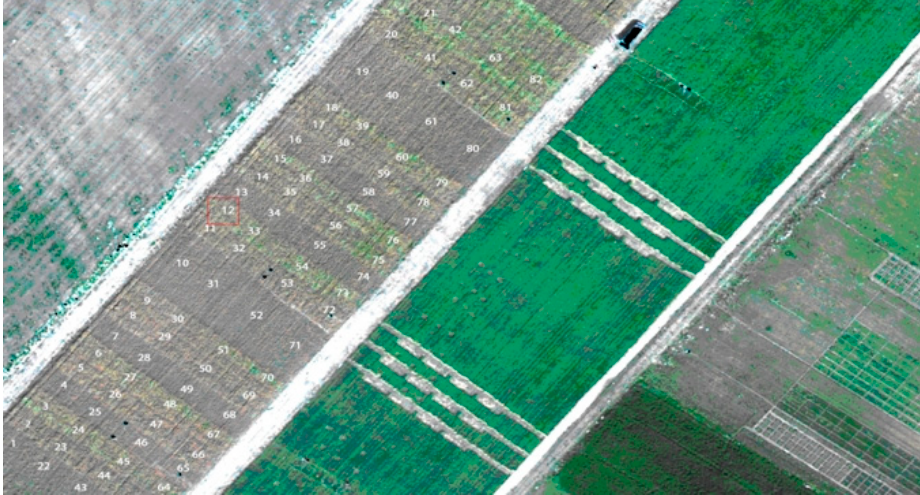
Figure 1. Image of an experimental field with sowing of spring wheat at the stage of milky-wax ripeness. Menkovsky branch of the Agrophysical Institute.